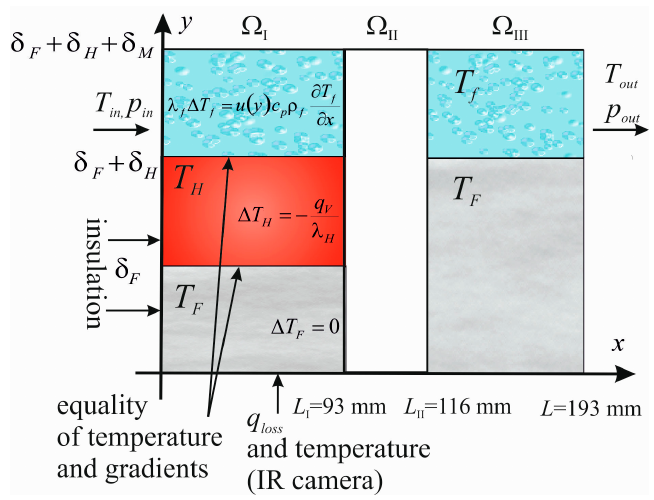
Figure 6. The test section and its schematic, illustrating the underlying model assumptions, (pictorial view, not to scale).